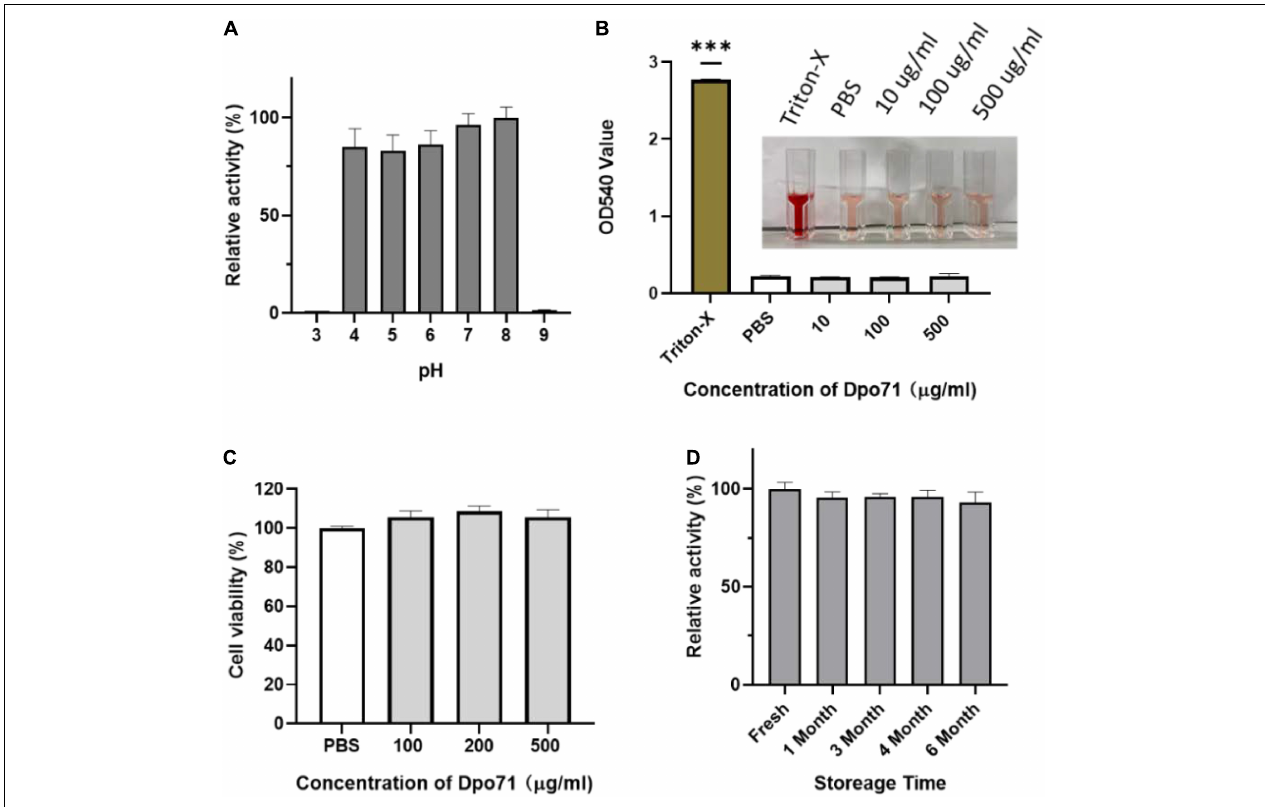
FIGURE 2 | Stability and toxicity of Dpo71. (A) The effect of pH on Dpo71 depolymerase activity. CPC turbidity assay was used to measure the polysaccharide extracts (CPS/LPS) degradation activity, the highest activity at pH 8 was set as 100%. (B) Hemolysis of red blood cells by Dpo71. PBS and 0.1% Triton X-100 in PBS as the negative and positive controls, respectively. ∗∗∗ indicated P < 0.001, Student’s t -test. (C) Cytotoxicity of Dpo71 against human cells (BEAS-2B). (D) Stability of Dpo71 after storage at 4 ◦ C. The polysaccharide extract (CPS/LPS) degradation activity of the freshly prepared enzyme was set as 100%. Data are expressed as means ± SD ( n =